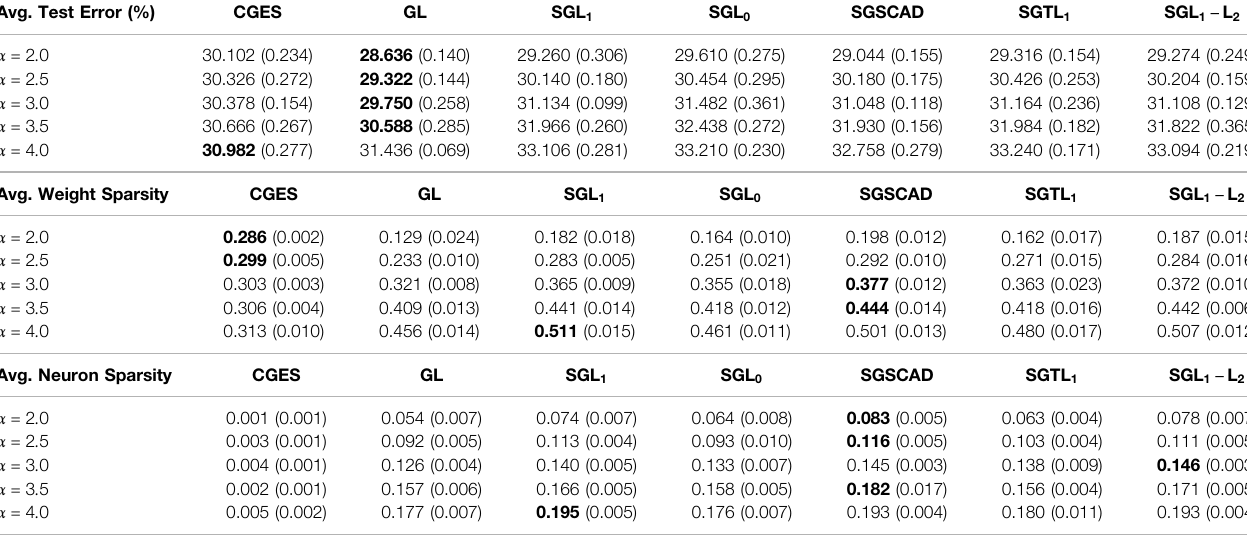
TABLE7| Averagetesterror,weightsparsity, andneuronsparsityofResnet-40modelstrainedonCIFAR100withlowesttesterrorsacross5runs.Standarddeviationsare in parentheses. Avg. Test Error